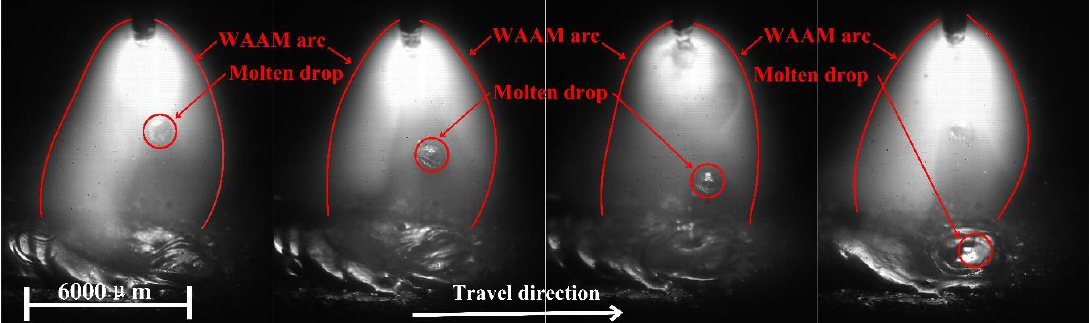
Figure 3. Image of the molten pool taken by a high-speed camera during the on-line cooling (OL) process.